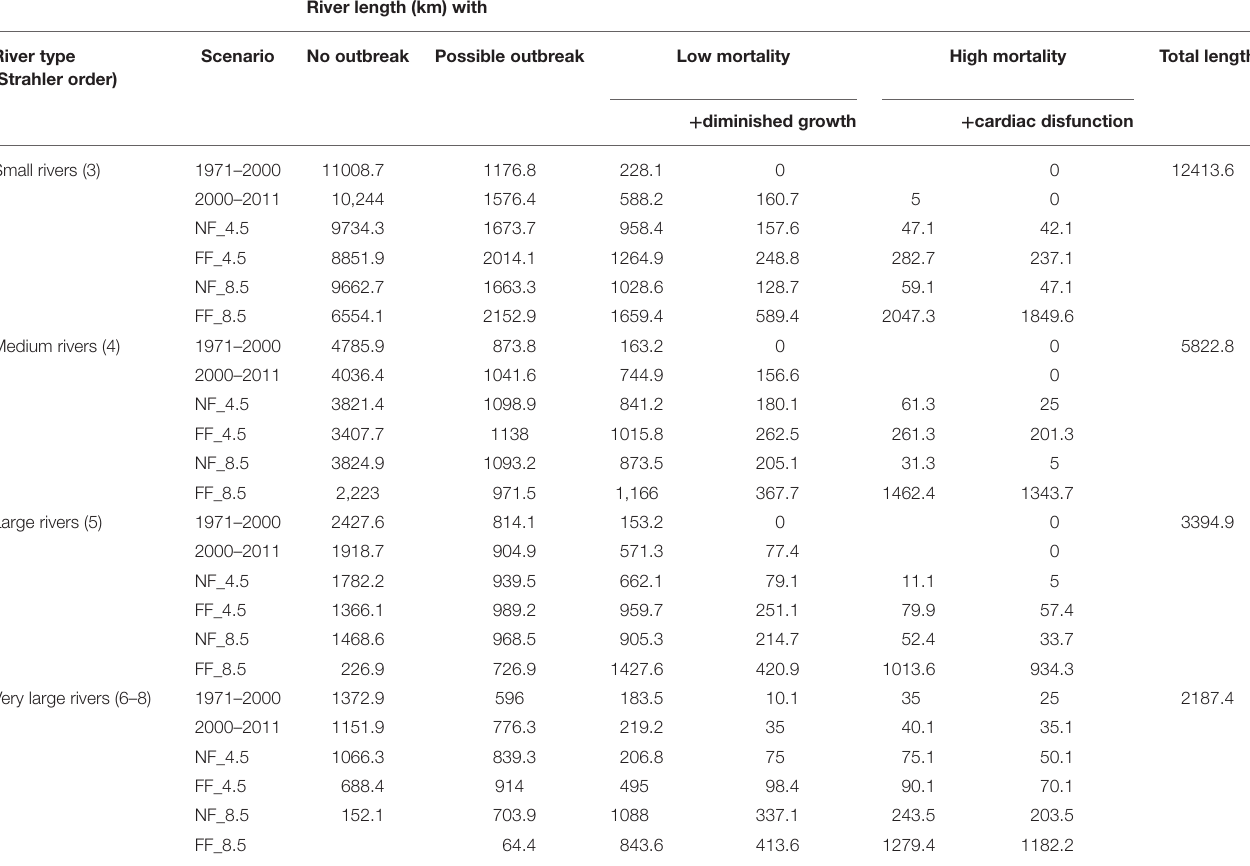
TABLE 5 | River network (km) with combined effects of outbreak and mortality due to PKD and thermally stressful conditions for S. trutta . River length (km) with